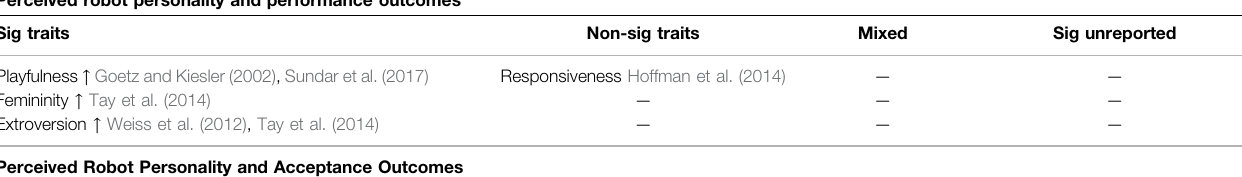
TABLE 7 | Robots ’ perceived personality traits impacts on outcomes by traits, where ↓ indicates a negative relationship and ↑ indicates a positive relationship. Perceived robot personality and performance